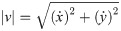
Motion of two fish in a circular shallow water tank.(A) Each fish is characterized by a position (x, y), velocity v, orientation θ and acceleration a. (B) Diagram of behavioral state transitions for the two fish with interaction. (C-D) A time window of length 1000 s shows the velocity and orientation of one fish (second fish not shown) from the data in [12]. The trajectory shows alternating regions of acceleration (blue = turning left, red = turning right) or deceleration (no shade), consistent with the states marked in B. (E) Velocity traces in the accelerating phase (data from C), shifted to the same initial value, have a sigmoidal functional form. Acceleration can be fitted empirically to a quadratic function, d|v|/dt = −a|v|2 + b|v| + c where |v|=(x˙)2+(y˙)2. This is shown in (F) for data containing 3000 accelerating intervals. Data from each accelerating window (dotted green) is fitted separately and then shifted and rescaled to a normal form |a| = −|v|2 (black). (G) Passive state shows an exponential decay of the velocity due to friction, evident by rescaling decelerating trajectories to the same initial value and plotting them on a log-linear scale.